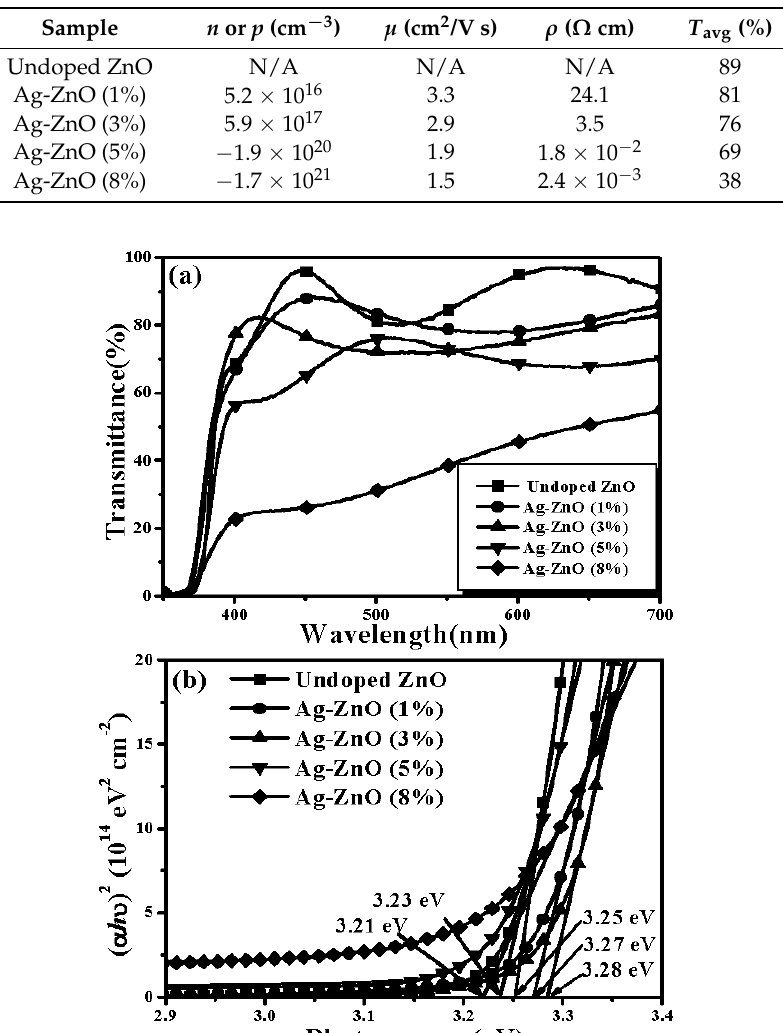
Table 1. Electrical properties of the undoped ZnO and ZnO films doped at various theoretical Ag atomic ratios annealed at 350 °C for 1 h under ambient air.